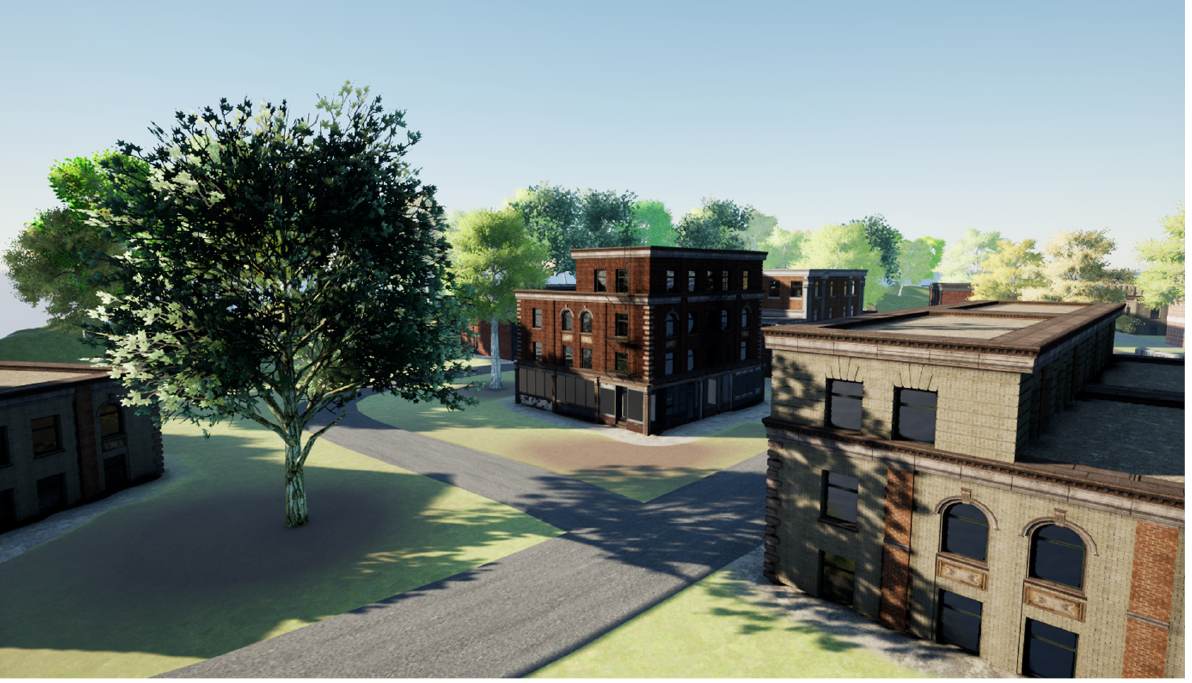
Figure 4. Example of an immersive large-scale planning scenario in a settlement (including streets, buildings, vegetation and shadows; own illustration by Dennis Edler and Timo Wiedenlübbert).